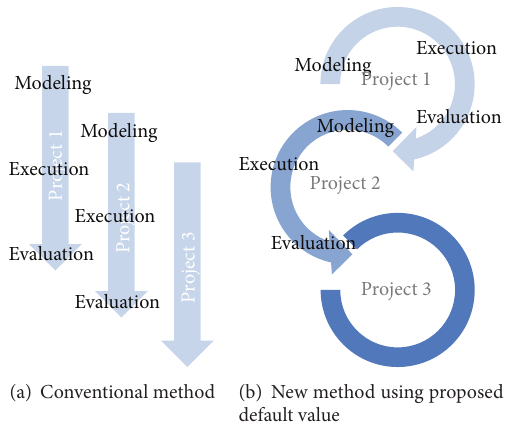
Figure 1: Image of simulation flow.